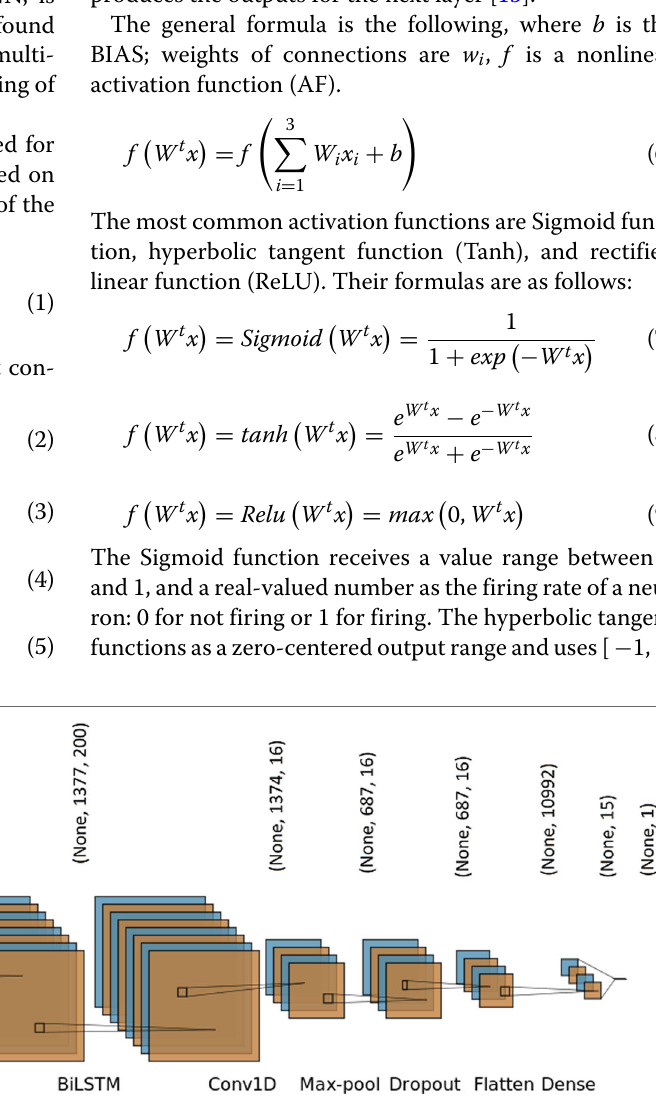
Neural network architecture